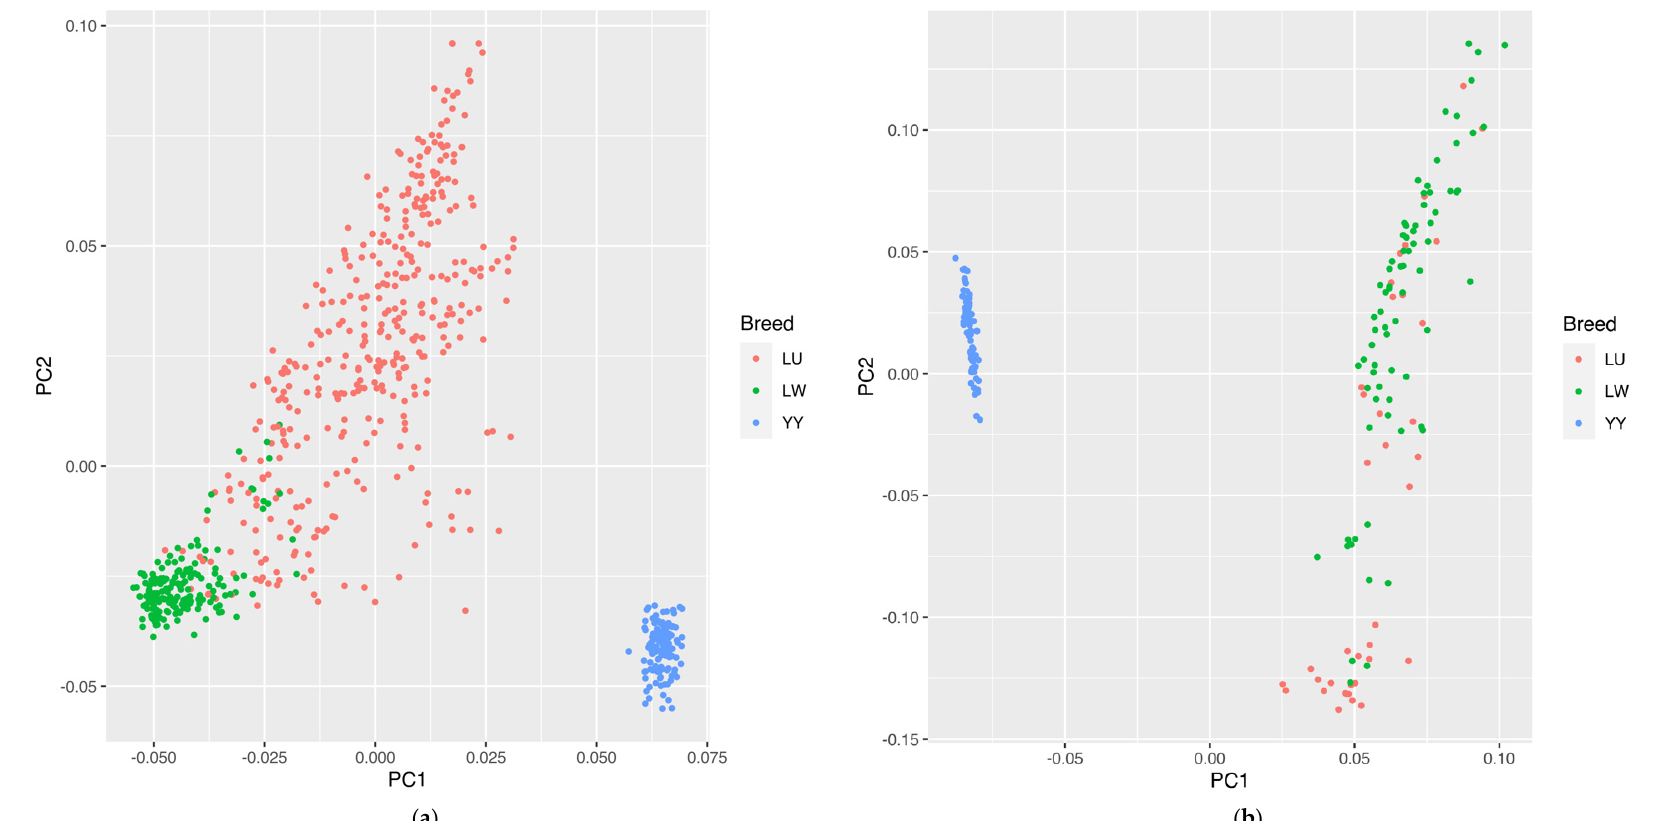
Figure 2. ( a ) PCA results of LU pig population by SNP chip. ( b ) PCA results of LU pig population by GGRS. Blue, red, and green circles represent YY, LU, and LW pigs, respectively.